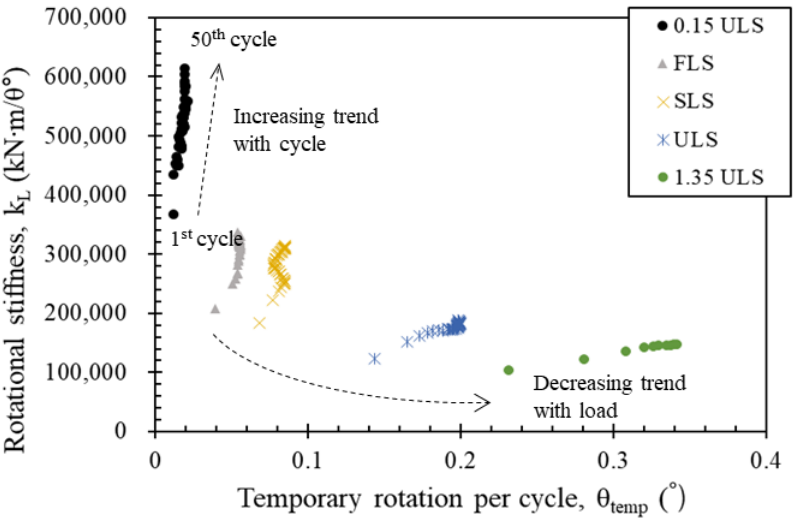
Figure 12. Cyclic stiffness – rotation curve under different load amplitudes.